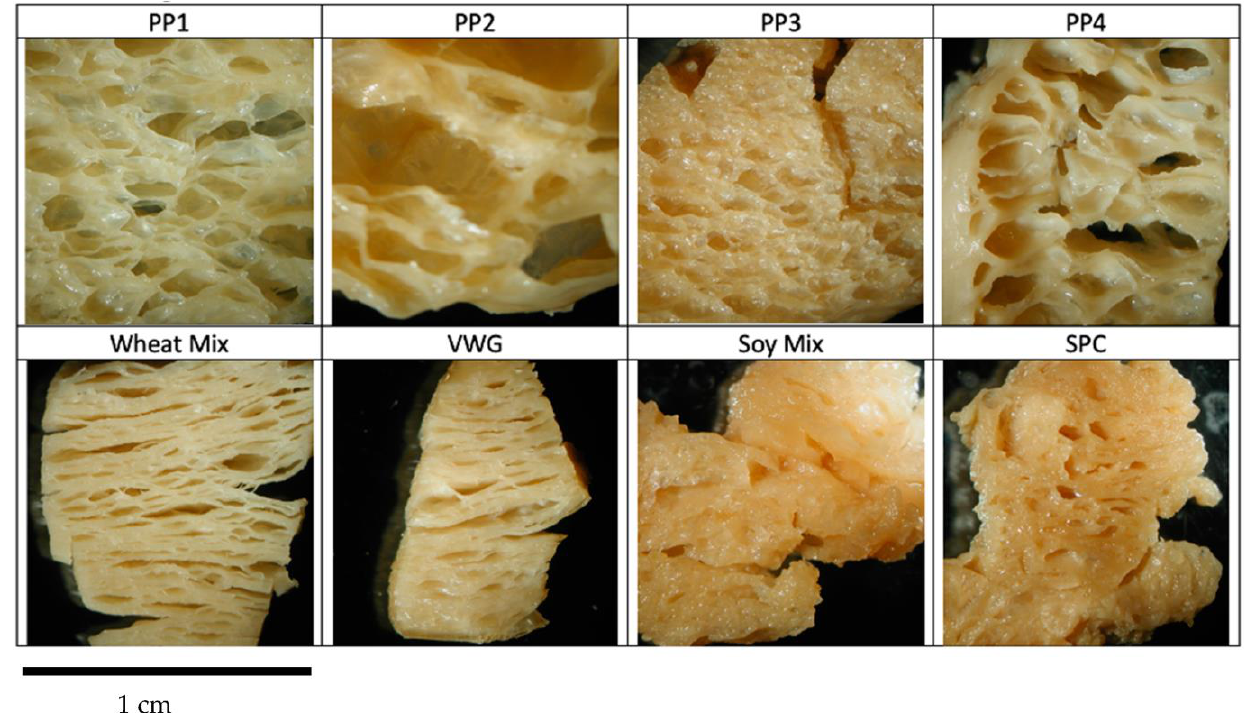
Figure 12. Longitudinal cross sections of whole extrudate pieces. Longitudinal pieces were cut along the direction of flow from the extruder. Each image is approximately 1 cm across.